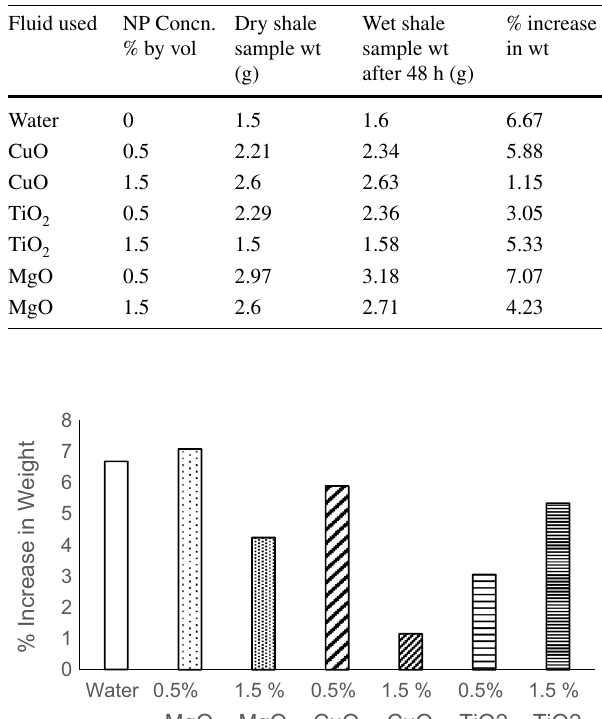
Fig. 5 Reactive clay content (lb/bbl) after being exposed to different fluids Table 5 Results of expansion by weight